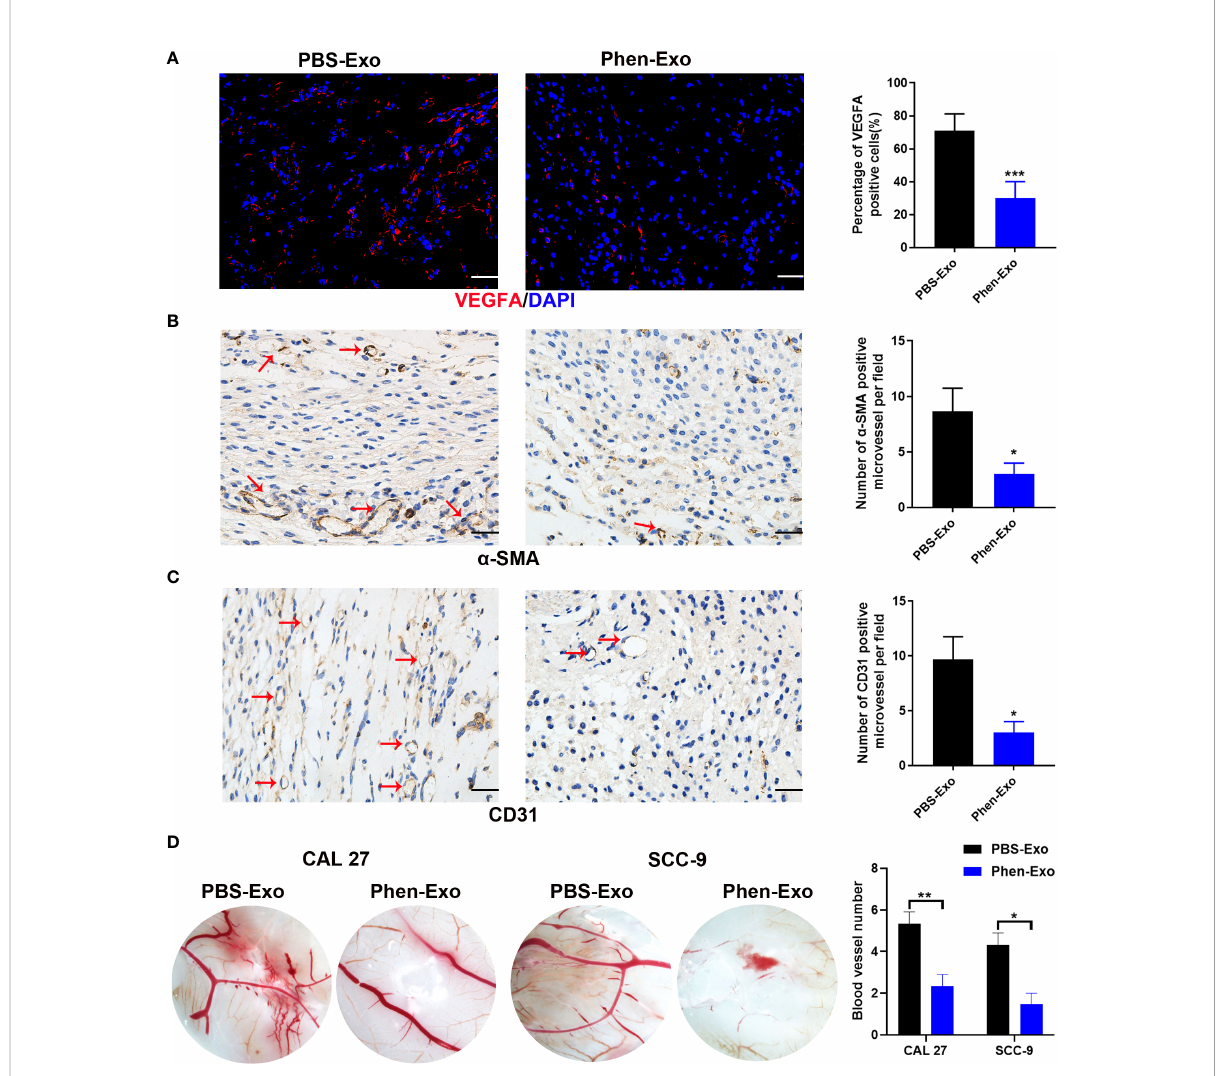
FIGURE 4 Exosomes derived from OSCC cells treated with phenformin (Phen-Exo) inhibit angiogenesis in vivo . (A – C) Immuno fl uorescence staining for VEGFA and IHC staining for a -SMA and CD31 in grafts formed following the injection of HUVECs together with PBS-Exo or Phen-Exo derived from CAL 27 OSCC cells. Blood vessels with a -SMA and CD31 positive cells in the grafts are indicated by red arrows. Bar graphs on the right show quanti fi cation of the numbers of VEGFA, a -SMA and CD31 positive cells. Scale bars = 50 m m in A, scale bars = 20 m m in (B – D) Images of blood vessels formed in CAM assays with treatment of PBS-Exo (100 m g/injection site) or Phen-Exo (100 m g/injection site) derived from CAL 27 cells or SCC-9 cells. Bar graph on the right shows quanti fi cation of blood vessel numbers observed in CAM assays. All experiments were performed three times, and error bars represent means ± SD in each group; P values are indicated with “ * ” , * indicates P<0.05, ** indicates P<0.01, *** indicates